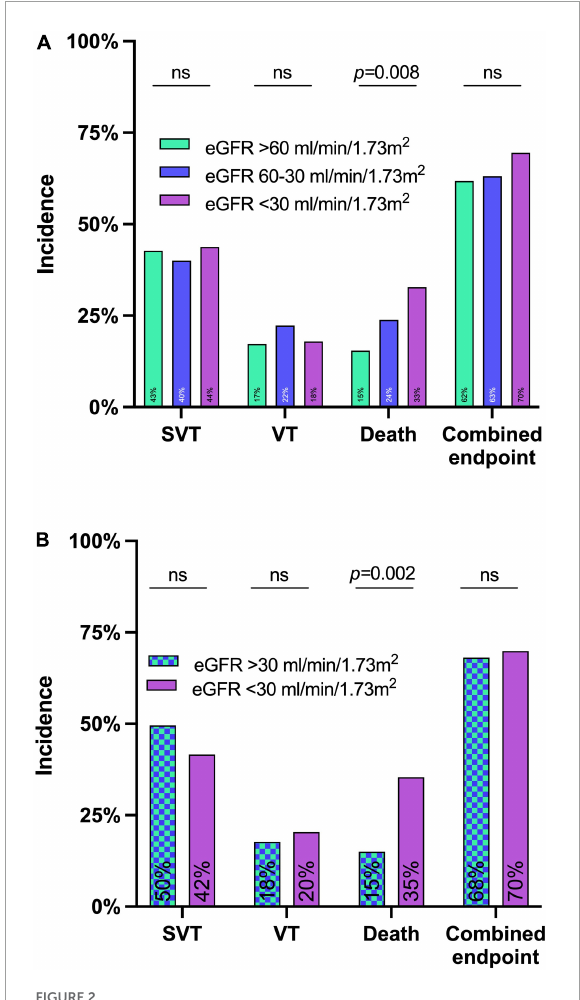
FIGURE2 Incidence of the primary and secondary endpoints until day 7 after levosimendan administration in the whole cohort (A) and the matched cohort (B) . eGFR before levosimendan administration had no significant impact on the combined endpoint of either death or supraventricular tachycardias (SVT) or ventricular tachycardias (VT) until day 7 in neither the whole cohort in panel (A) nor the matched cohort in panel (B)